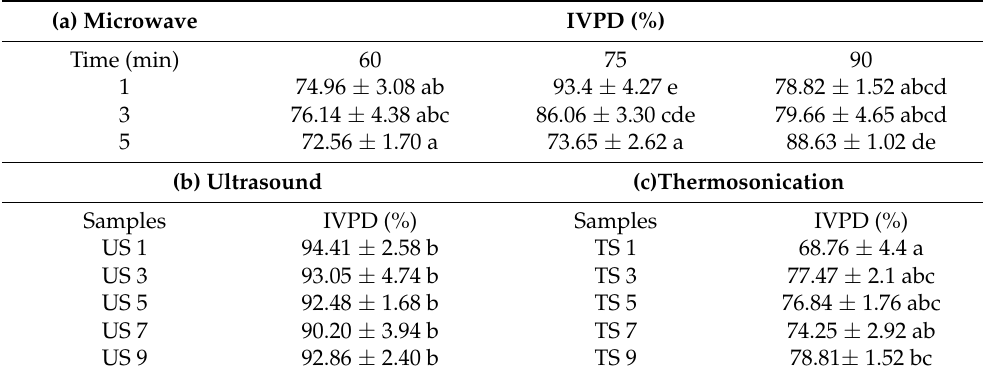
Table 3. In vitro protein digestibility of microwave-processed samples (a), ultrasound-processed samples (b), and thermosonicated samples (c). Note: The values are the mean with the standard error. The IVPD (%) of control was 84.42%; small letters indicate the lack of a significant difference at different processing times ( p > 0.05) based on ANOVA and Tukey’s